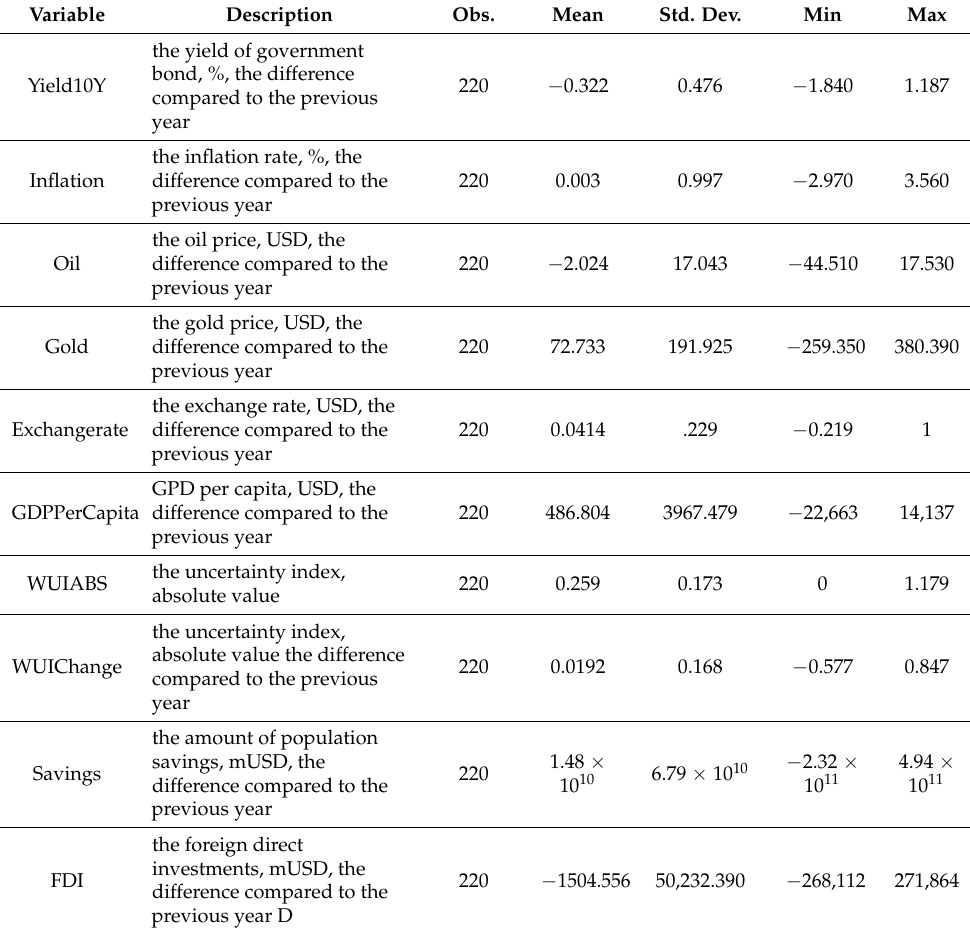
Table 1. The descriptive statistics of the